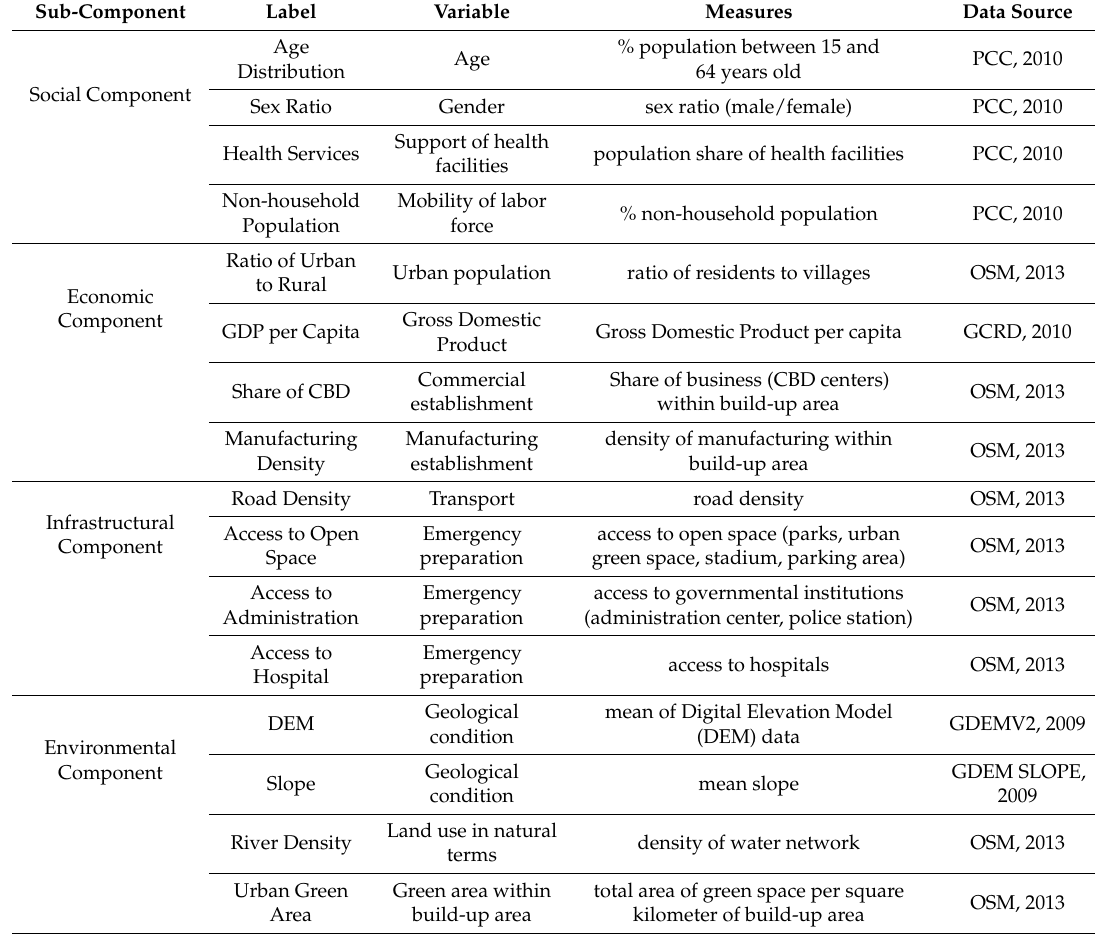
Table 2. Variables representing the four subcomponents of disaster